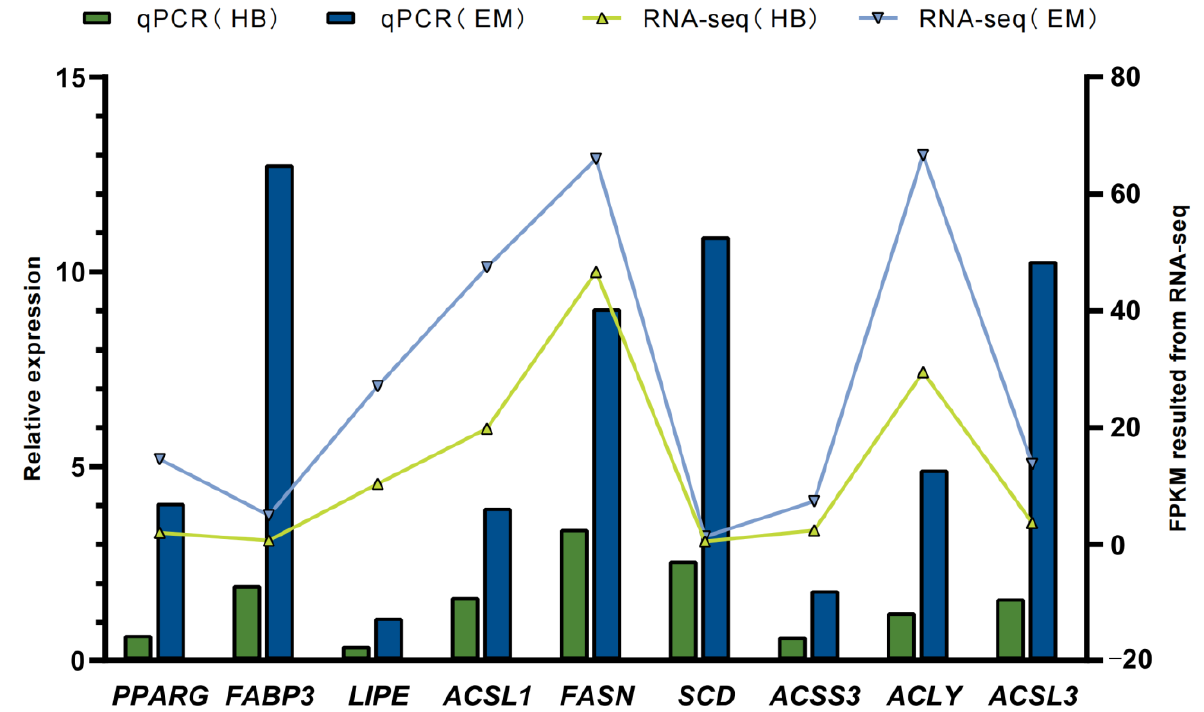
Figure 3. Validation of RNA-seq data by qRT-PCR. The line graph represents the FPKM value of RNA sequencing, and the bar graph represents the relative quantitative results of qRT-PCR.